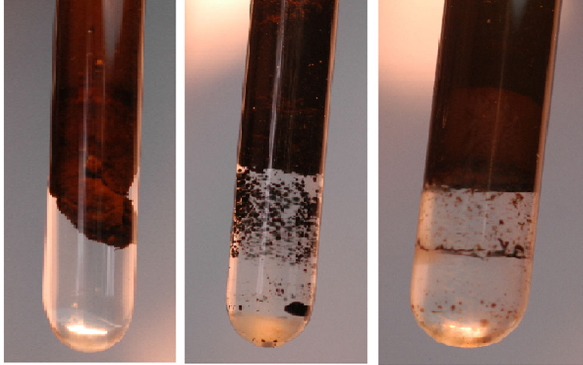
Fig. 7 IFT between oil/brine with various concentrations of silica nanoparticle